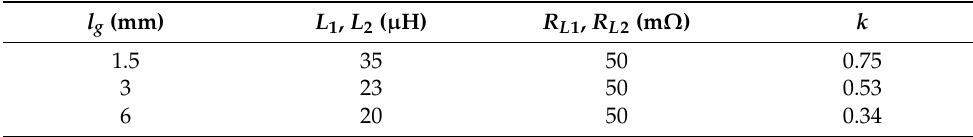
Table 6. Custom IPT coils measurement data.